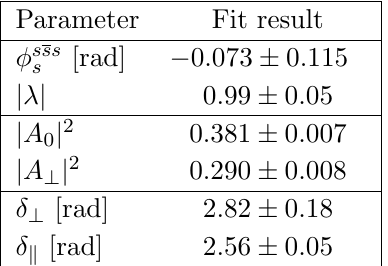
Table 3 . Results of the decay-time-dependent, polarisation-independent (cid:12)t for the CP -violation (cid:12)t. Uncertainties shown do not include systematic contributions.